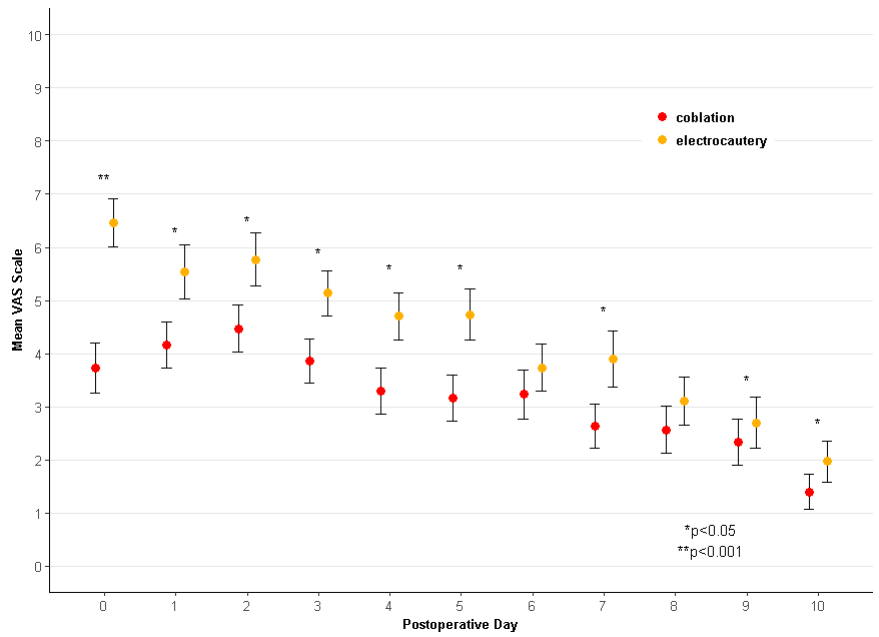
Figure 4. Mean postoperative pain scores according to visual analogue scale (VAS). Significantly reduced VAS pain scores are noted on the coblation side compared to the electrocautery side during postoperative 10 days, except days 6 and 8.